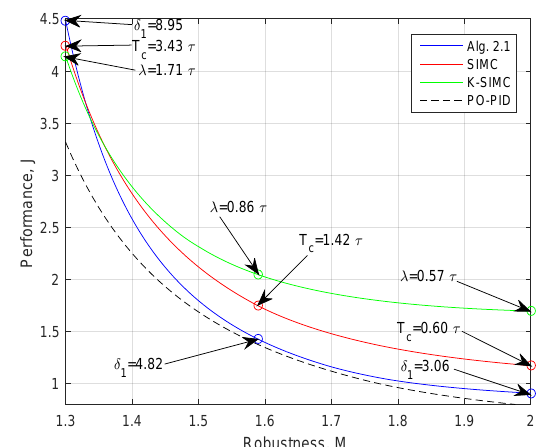
Figure 8: Example 3.5: Performance vs. robustness, J vs. M s trade-off curves. Comparing Alg. 2.1, SIMC and K-SIMC vs. the PO-PID con-